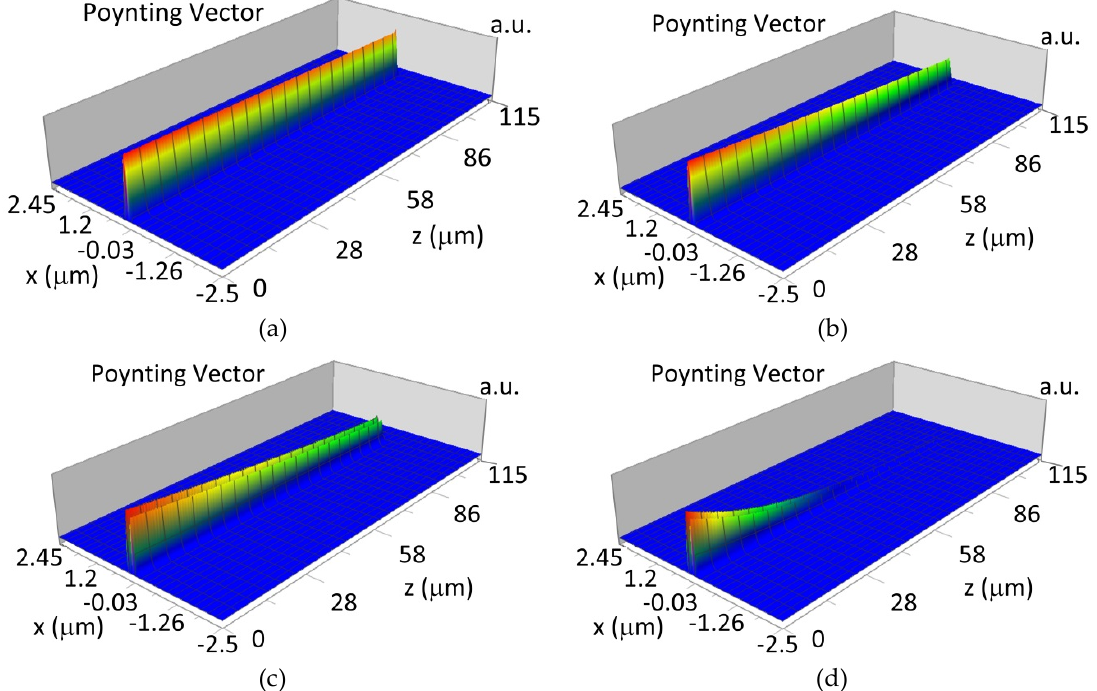
Figure 13. Propagation light in multi-mode waveguide structure for d w = 188 nm, λ = 436 nm (Poynting vector): ( a ) TE00, Hb O2 , ( b ) TE00, Hb, ( c ) TE01, Hb O2 , ( d ) TE01, Hb.